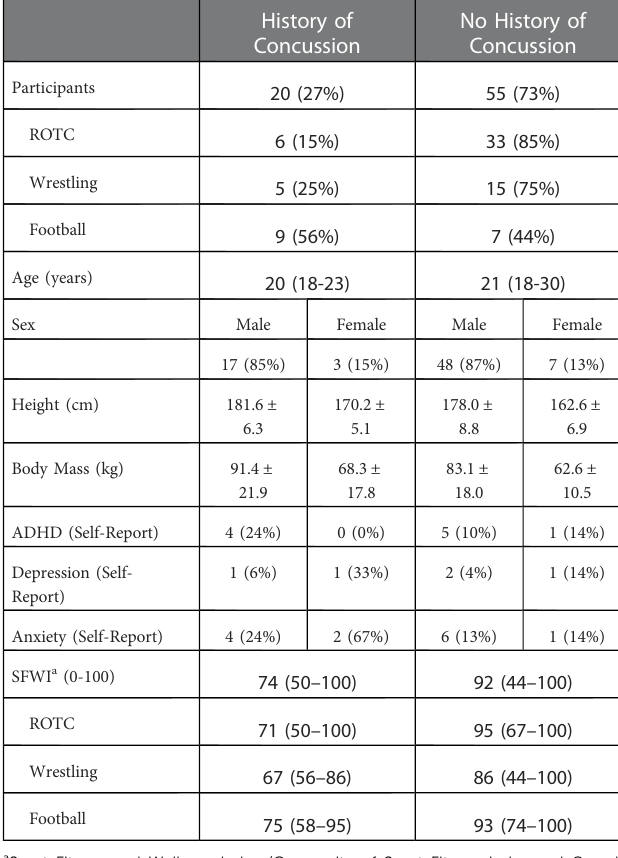
TABLE 1 Cohort characteristics: count (percentage), mean±standard deviation, or median